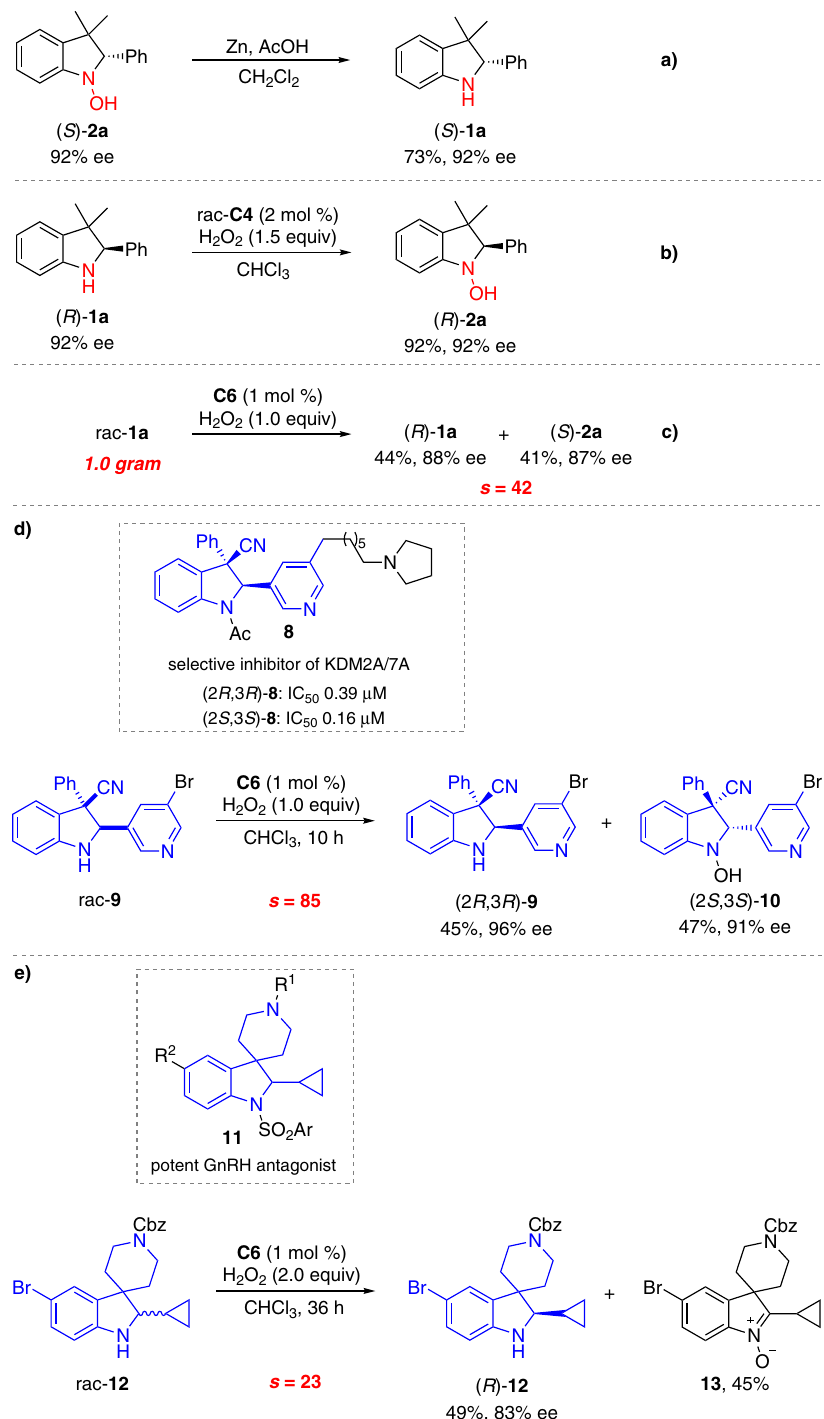
Fig. 5 Synthetic applications. a Reduction of hydroxylamine ( S )- 2a. b Oxidation of indoline ( R )- 1a . c Gram-scale experiment. d Late-stage enantio- differentiating oxygenation intermediates of KDM2A/7A. e Late-stage enantio-differentiating oxygenation intermediates of GnRH